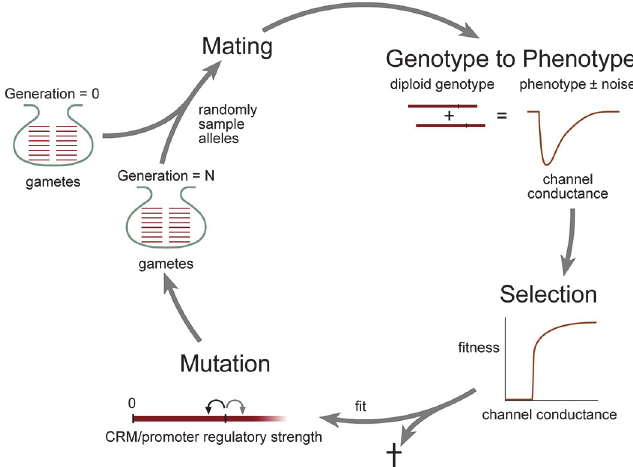
Fig 1. Schematic representation of the regulatory evolution model. The phenotype (channel peak conductance) of each individual was determined by random selection of two alleles from a pool of alleles (gametes). Channel conductance was directly proportional to the sum of the strength of the two alleles (see Methods), with or without a component of phenotypic noise. Fitness functions based on axonal electrophysiological performance were used to determine which individuals contributed genetic material to the next generation. This cycle repeats indefinitely. Random mutation of gamete DNA (channel gene promoter/CRM function) was biased towards a reduction in regulatory strength (reduced rate of mRNA transcription). In the simulations, mutation was performed immediately before selection in order to minimize computational costs but the results are equivalent to the natural order, where mutations would occur during gamete formation, as shown in the figure.